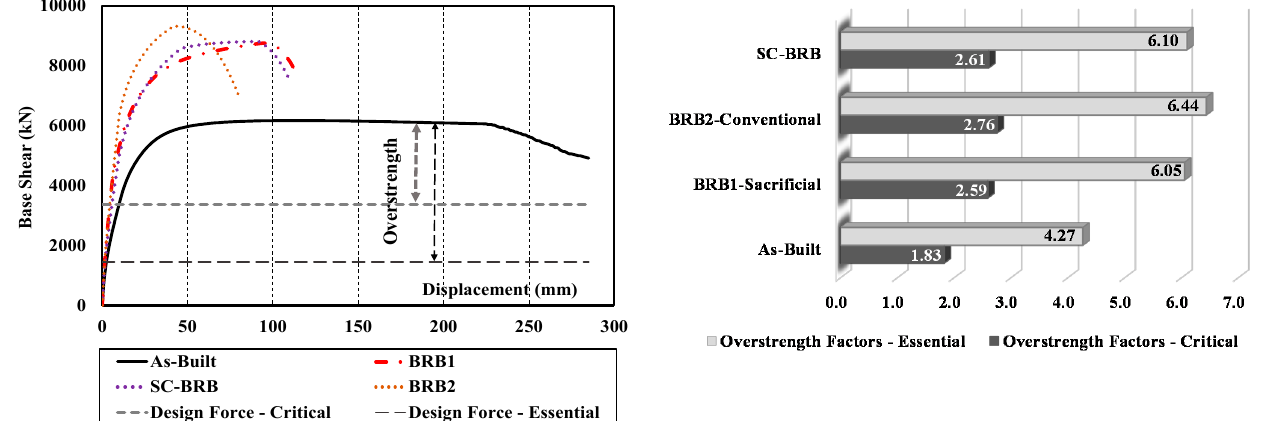
Figure 22. Comparison of the lateral capacity ( left ) and overstrength ( right ) in the transverse direction of the as-built and retrofitted bridges using different techniques.